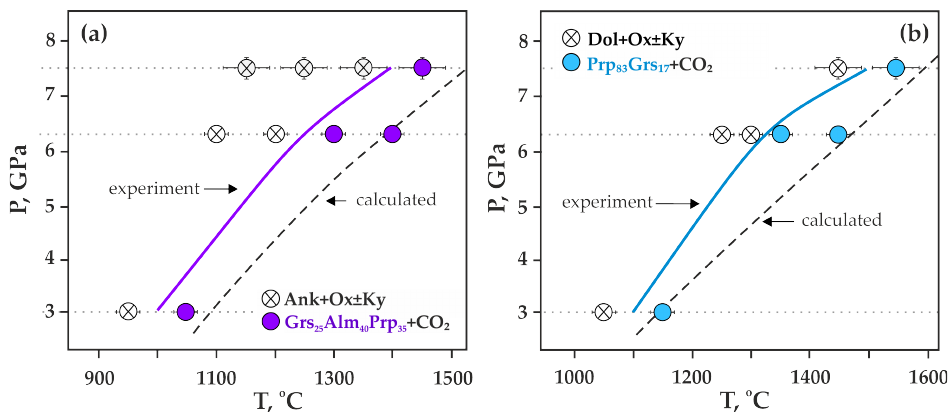
Figure 8. P,T diagrams with experimental parameters and results (this study): ( a ) Ca(Mg,Fe)(CO 3 ) 2 -SiO 2 -Al 2 O 3 system, ( b ) CaMg(CO 3 ) 2 -SiO 2 -Al 2 O 3 system; dashed lines—calculated position of the reactions of complete decarbonation—Grs 50 Prp 25 Alm 40 (a) and Grs 50 Prp 50 (b).